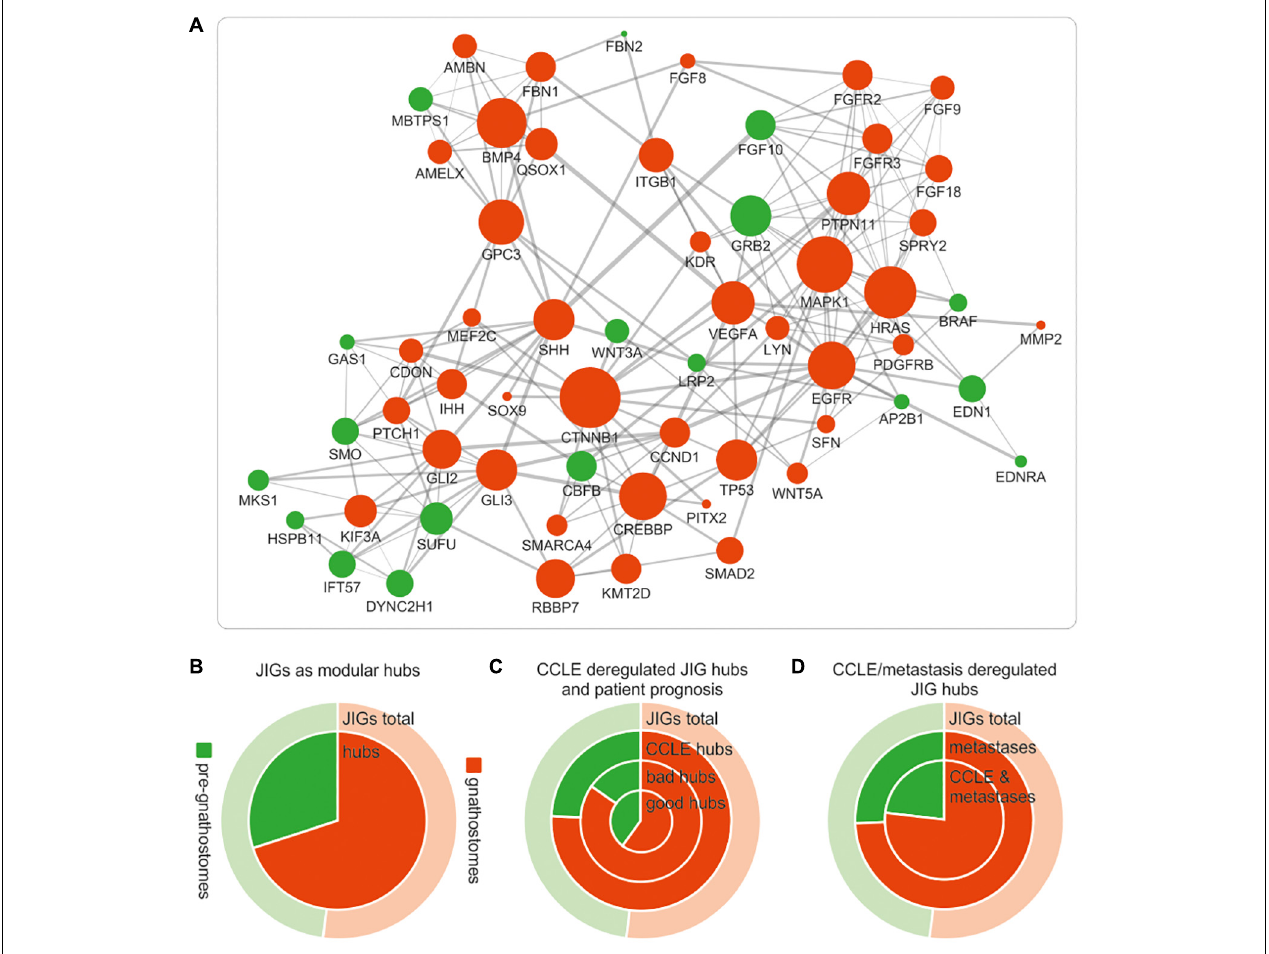
FIGURE 7 | Deregulations of gnathostome-specific hubs of the JDN are more frequent associated with invasive and metastatic stages, as opposed to pre-gnathostome hubs. (A) Functional interaction network (confidence interaction score ≥ 0.9) of the gnathostome-specific and pre-gnathostome JIG hubs. The size of the nodes is proportional to the node degree in the “original” JDN network in Figure 3d . The 60 nodes that represent intra- and inter-modular hubs in the original network appear to be interconnected and form a rather dense network. (B) The gnathostome-specific genes make up 52% (159) of all 305 JIGs (outer ring “JIG total,” red), whilst the proportion of gnathostome hubs is significantly enriched in relation to the pre-gnathostome (inner circle “hubs,” red). (C) More gnathostome-specific hubs that are deregulated in CCLE cells are correlated with worse prognosis in PanCan cohort (ring “bad hubs,” red). In contrast, more pre-gnathostome hubs tend to correlate with favorable than poor prognosis (compare ring “bad hubs” with inner circle “good hubs,” green). (D) More gnathostome-specific hubs are found deregulated, compared to the pre-gnathostome ones, in metastatic lesions (inner ring). This preference is more pronounced for hubs commonly deregulated in metastatic samples and CCLE cells (inner